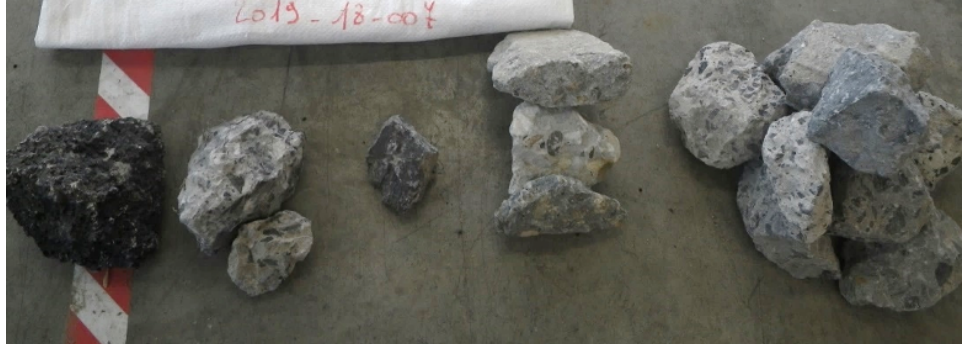
Figure 1. Sample 4: low quality concrete waste fraction 20-56 mm.